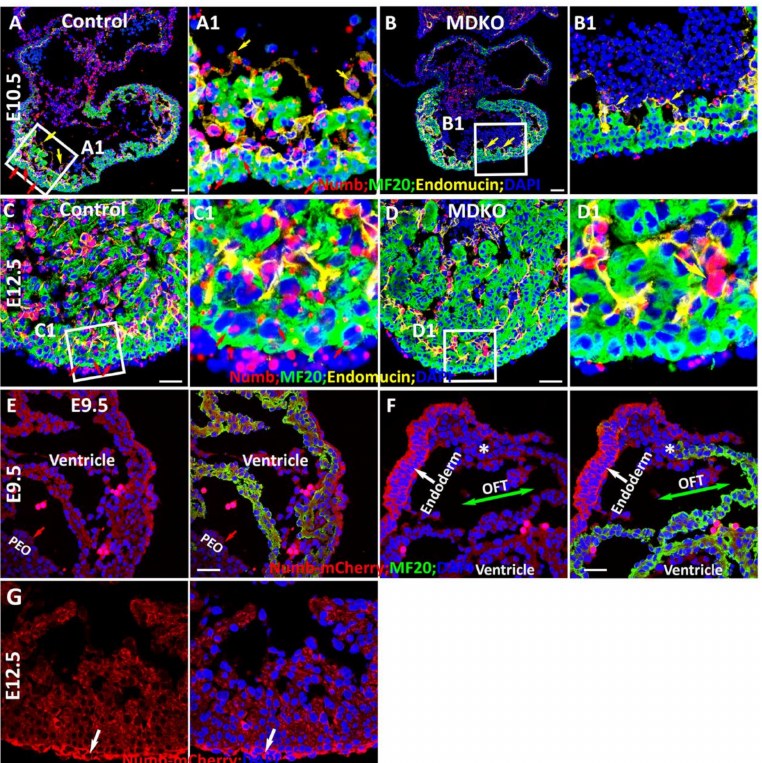
Figure 2. Spatiotemporal expression of Numb during myocardial morphogenesis. ( A ( A1 )– D ( D1 )) Numb is expressed in epicardial cells, endocardial cells and cardiomyocytes at E10.5 and E12.5 ( A ( A1 ), C ( C1 )). The specificity of Numb in RNAScope and relative enrichment in endocardial cells is confirmed and observed in the MDKO ( B ( B1 ), D ( D1 )). Red arrows point to the cardiomyocytes and yellow arrows point to the endocardial cells in ( A – D ). ( E , F ) The Numb expression pattern was further determined by a mCherry::Numb knockin line. Numb is not enriched in pro-epicardial cells at E9.5 ( E ) but is enriched in epicardial cells at E12.5 ( F ). Numb is ubiquitously expressed in trabecular and compact cardiomyocytes and did not display an asymmetric distribution between them ( E , F ). Epicardial cells are enriched with Numb ( G ). Red or white arrows point to the cells that express Numb. * Indicates a transition from MF20 negative cells to MF20 positive cells in OFT. Scale bars: 100 µ